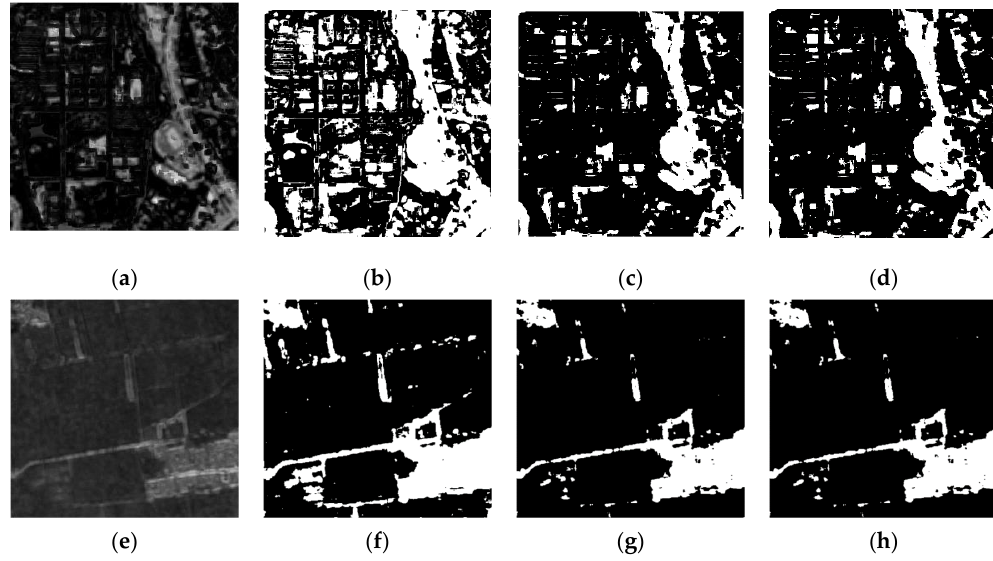
Figure 7. The change magnitude images and binary change maps obtained by LSSC. ( a , e ) denote change magnitude images for the first data and the second data set, respectively. ( b – d ) are binary change maps for the first data set generated by LSSC-EM, LSSC-FCM, and LSSC-Kmeans, respectively. ( f – h ) are binary change maps for the second data set generated by LSSC-EM, LSSC-FCM, and LSSC-Kmeans, respectively.